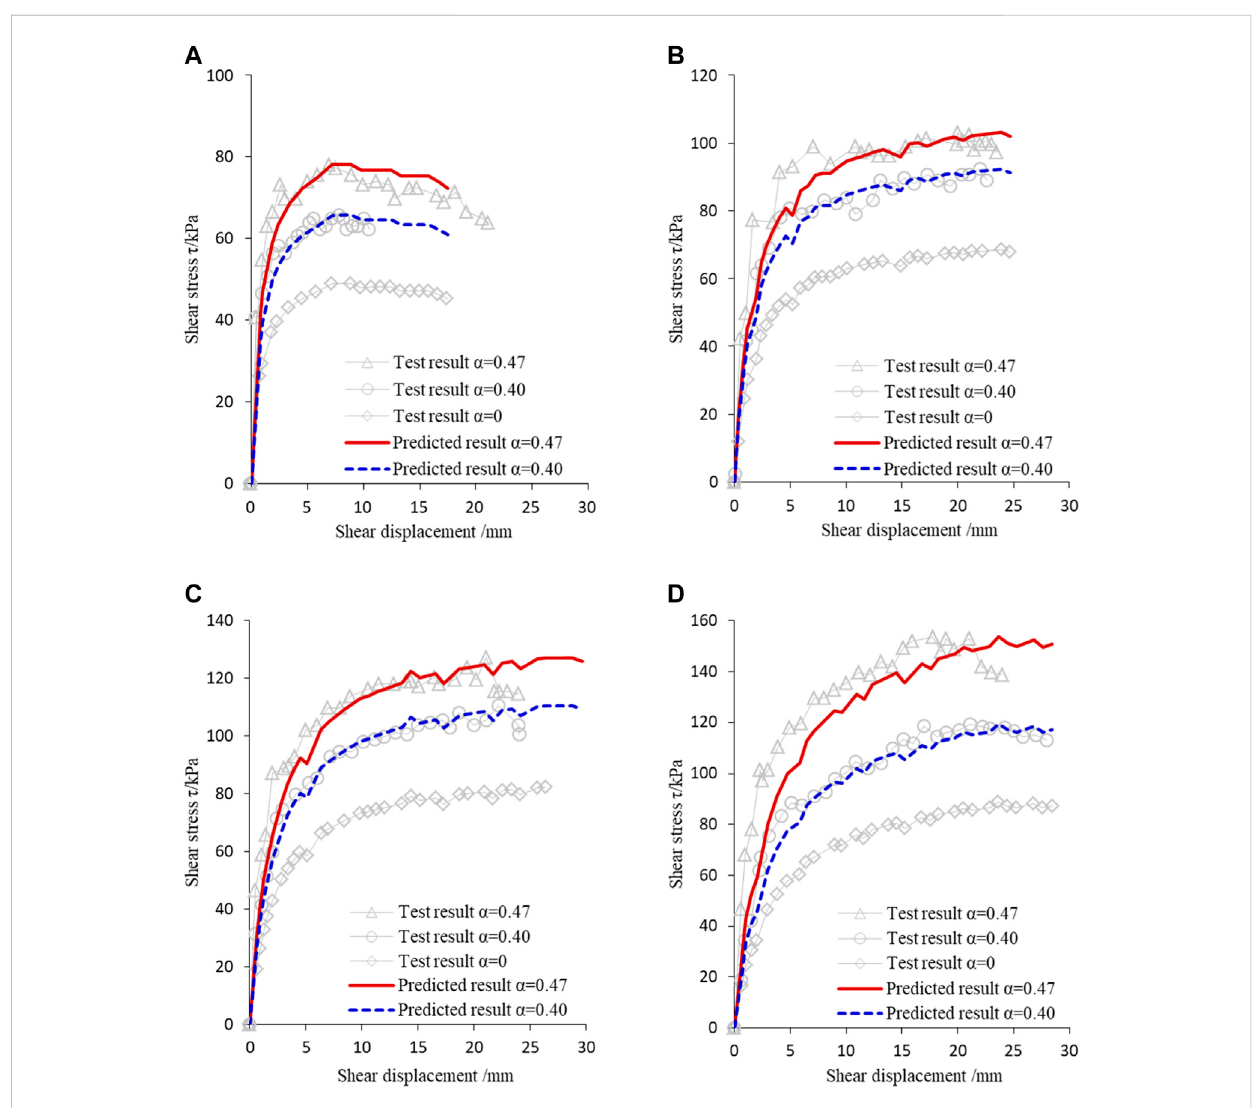
FIGURE 9 Comparisonsofshearstress-sheardisplacementrelationshipbetweentestandpredictedresults. (A) Normalstress36 kPa, (B) Normalstress72 kPa, (C) Normal stress 108 kPa, and (D) Normal stress 144 kPa.